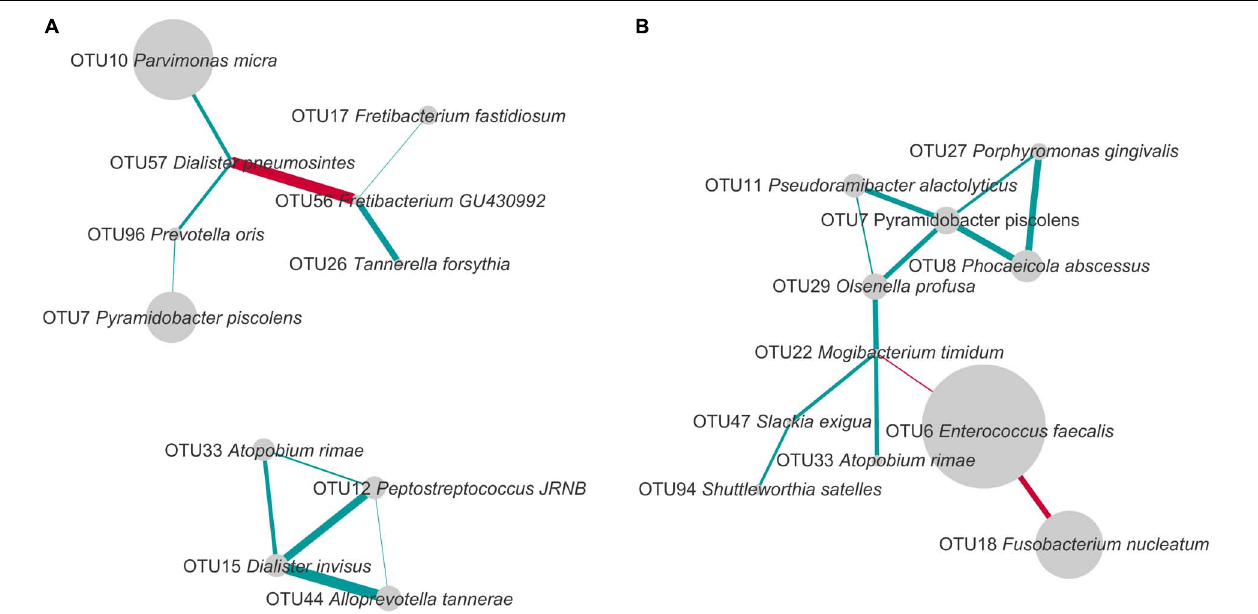
FIGURE 5 | Co-occurrence and exclusion patterns among most abundant OTUs in PAP (A) and SAP (B) in root canal samples. OTUs found in at least eight samples and with a minimal average relative abundance of 1% (considering all root canal samples) were analyzed. The edges represent positive (blue) and negative (red) Spearman correlations. Only correlations with Spearman R > 0.5 or R < –0.5 are presented. The line thickness is proportional to the absolute value of the Spearman’s correlation. Node sizes reflect average relative abundance of each OTU. PAP, primary apical periodontitis; SAP, secondary apical periodontitis.